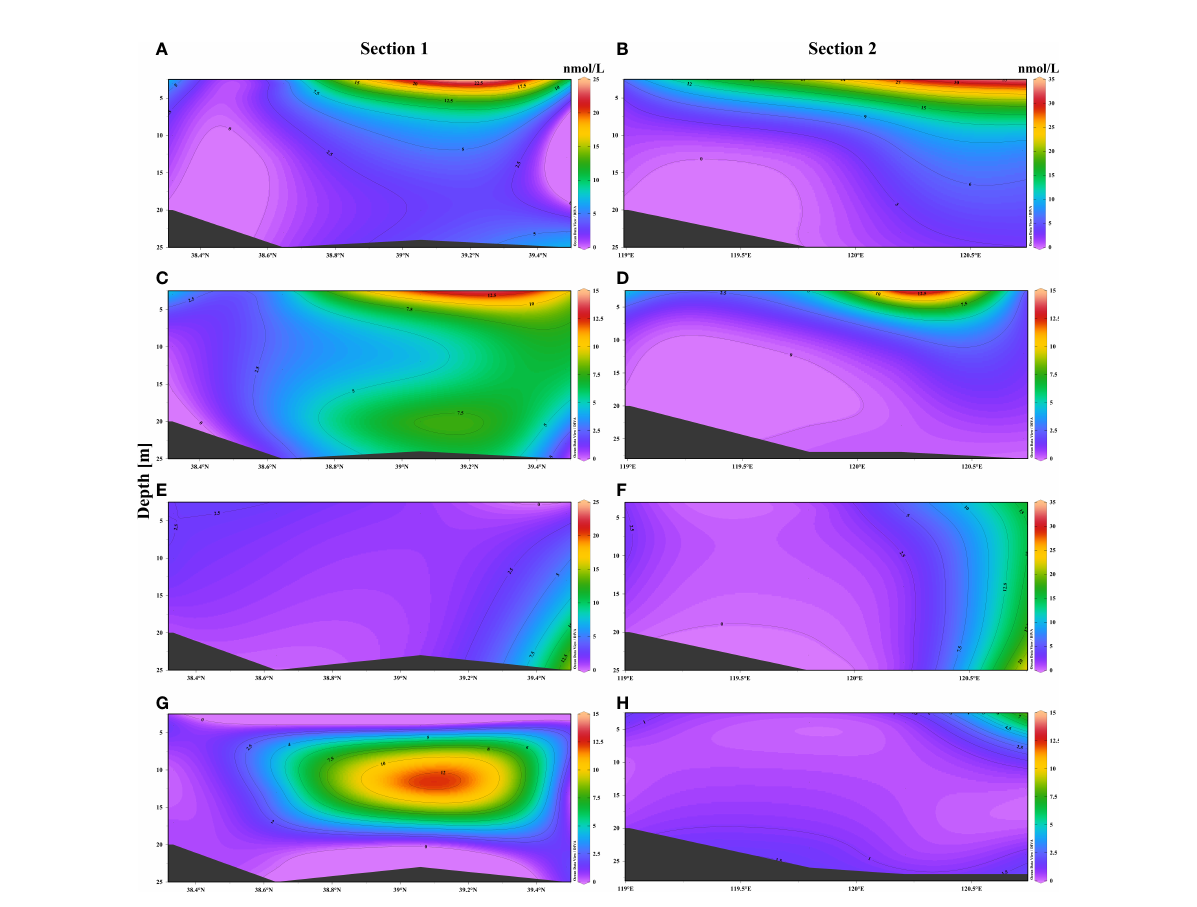
FIGURE 5 Vertical distributionof DMSPp and DMSPd in the waters of BS (sections 1 and 2) in summerand autumn. Distributionof DMSPp in (A) and (B) summer. Distributionof DMSPd in (C) and (D) summer. Distributionof DMSPp in (E) and (F) autumn. Distribution ofDMSPd in (G) and (H)